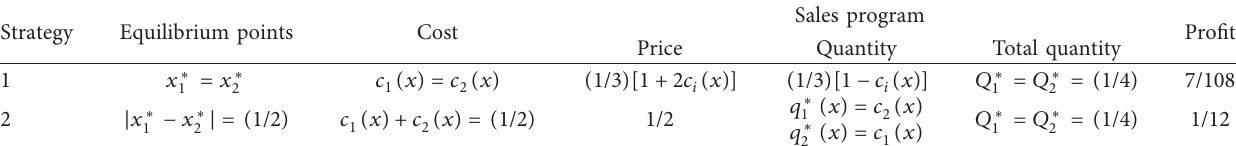
Table 1: Location game strategies based on possible equilibrium